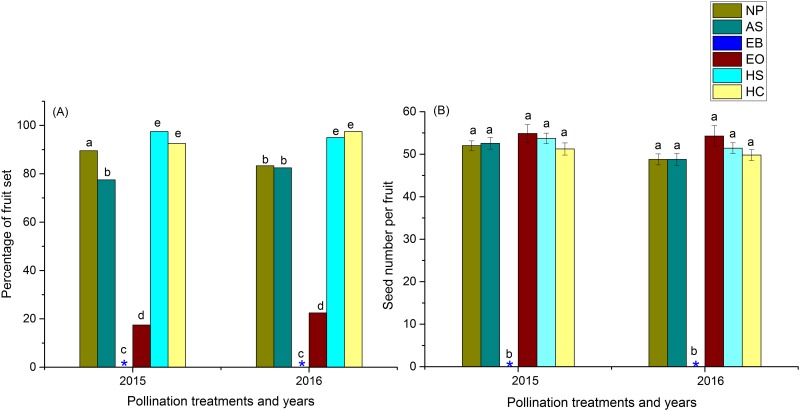
Fruit set percentage and seed number per fruit among different pollination treatments in R. alpina.Error bars represent the standard error of mean. Different lowercase letters above the bar represent the statistical difference at P<0.05. Asterisk marks in the bar diagram represent zero fruit and seed set. NP = Natural pollination; AS = Autonomous selfing; EB = emasculated- bagged (Apomixis); EO = Emasculated-open pollination; HS = hand self–pollination and HC = Hand cross pollination respectively.